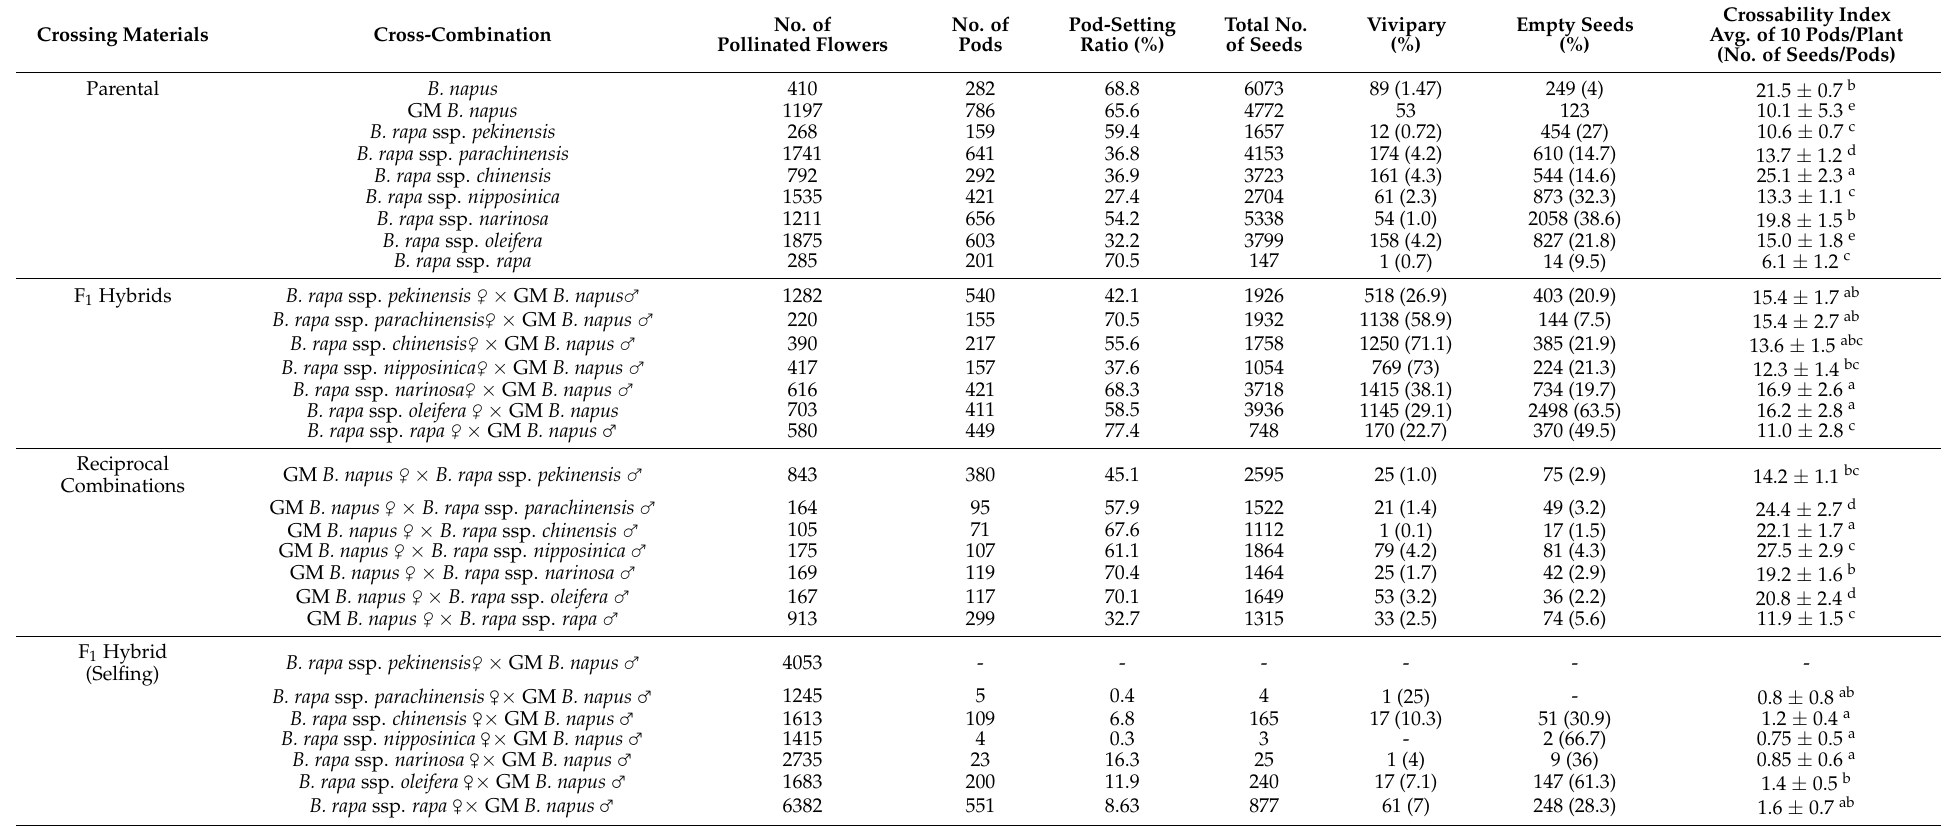
Table 1. Details of cross-compatibility with B. rapa ssp. and GM B. napus